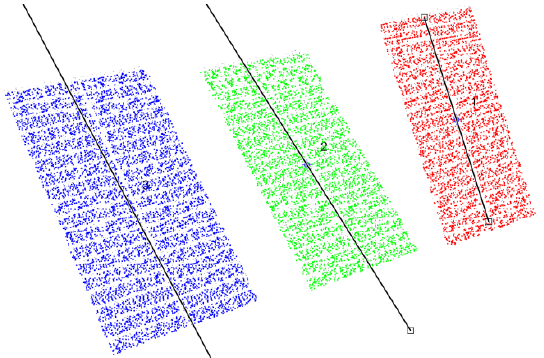
Figure 11. Principal component of each module (situation in which there is a vertical fault in the tracker of the right PV module).